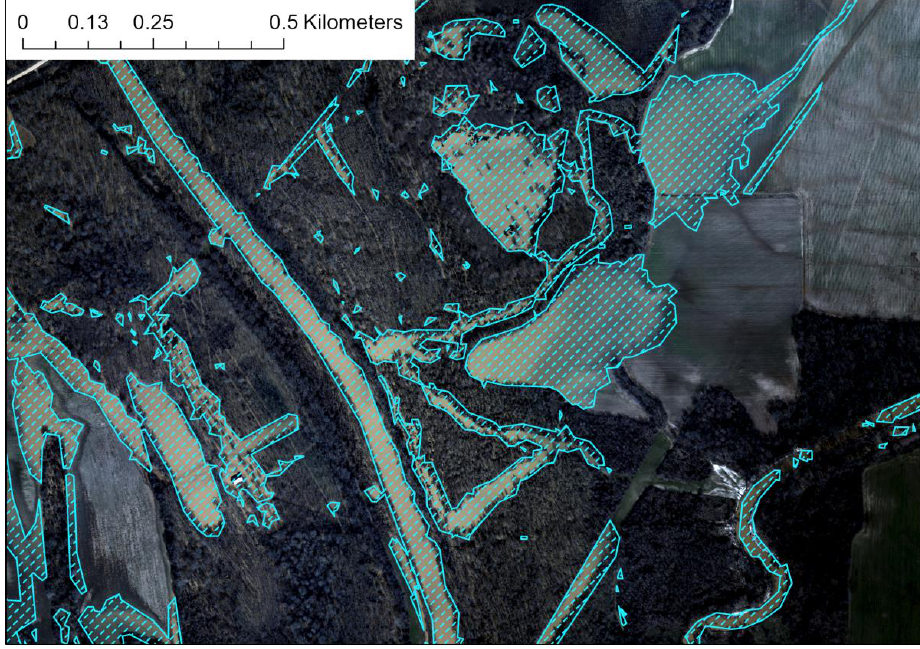
Figure 6. Inundated area based on a land-water mask generated from the Feb. 25, 2019 flight.